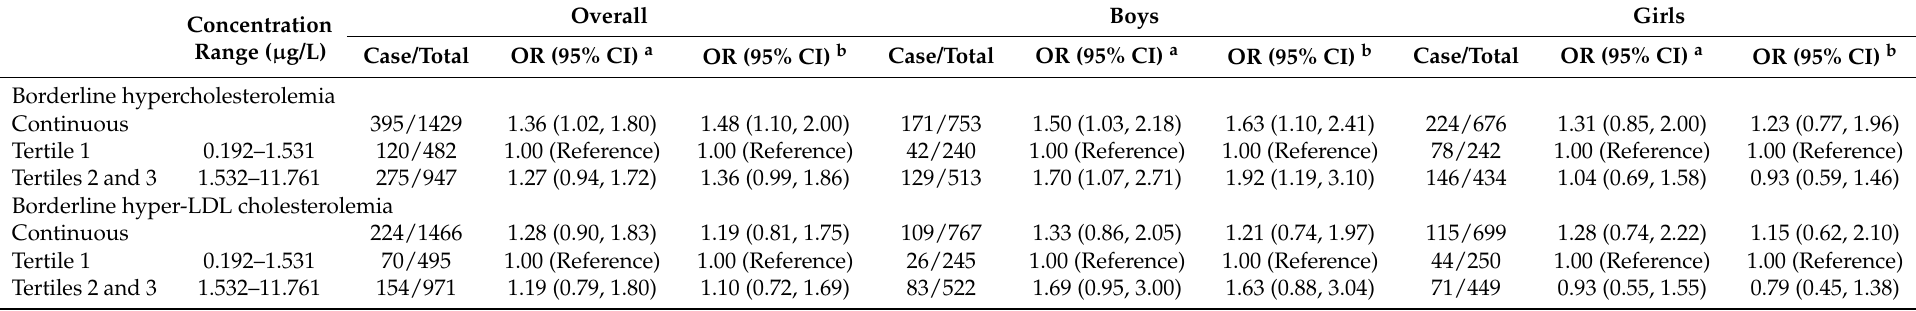
Table 4. Associations between blood Hg concentration and prevalence of borderline hypercholesterolemia and hyper-LDL cholesterolemia according to sex.